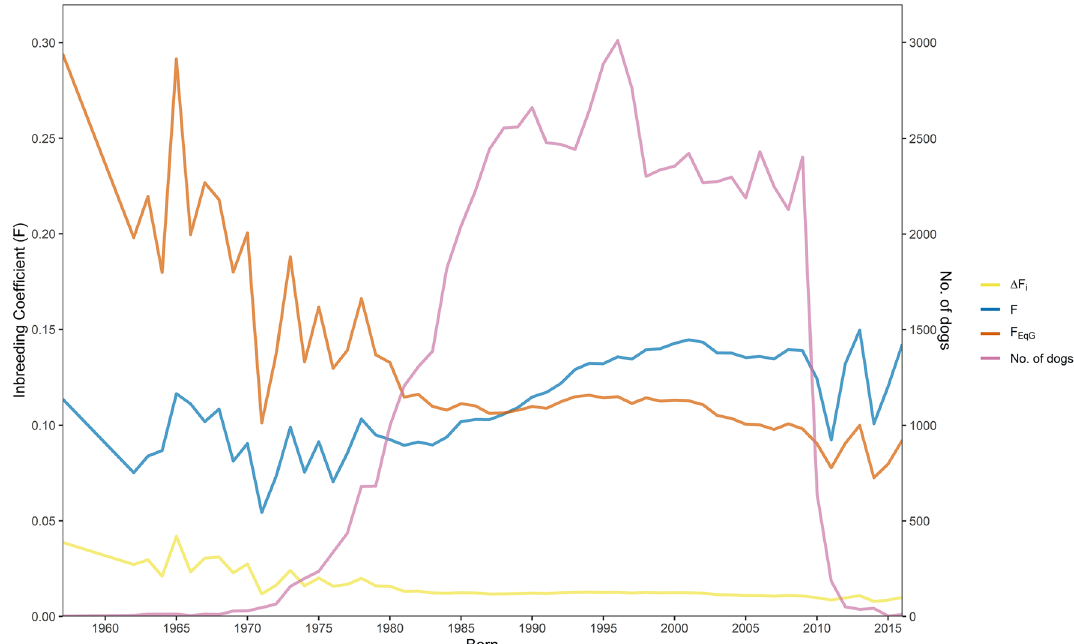
Figure 1. Inbreeding coefficient (F), individual change in inbreeding (ΔF i ), inbreeding adjusted to mean EqG (10.75) in the population (F EqG ), and number of dogs over time. Dogs that had only one complete generation or where inbreeding coefficients could not be calculated due to incomplete pedigree information were excluded, as well as years that had only one dog available.